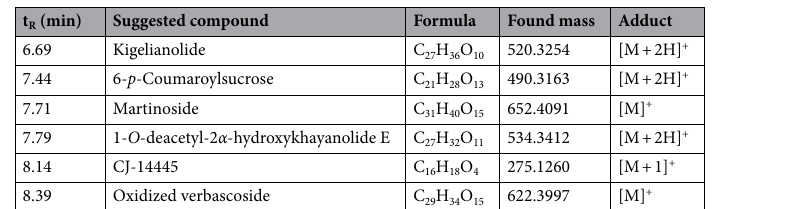
Table 3. UPLC-TOF–MS report of ZF 52 EtOAc